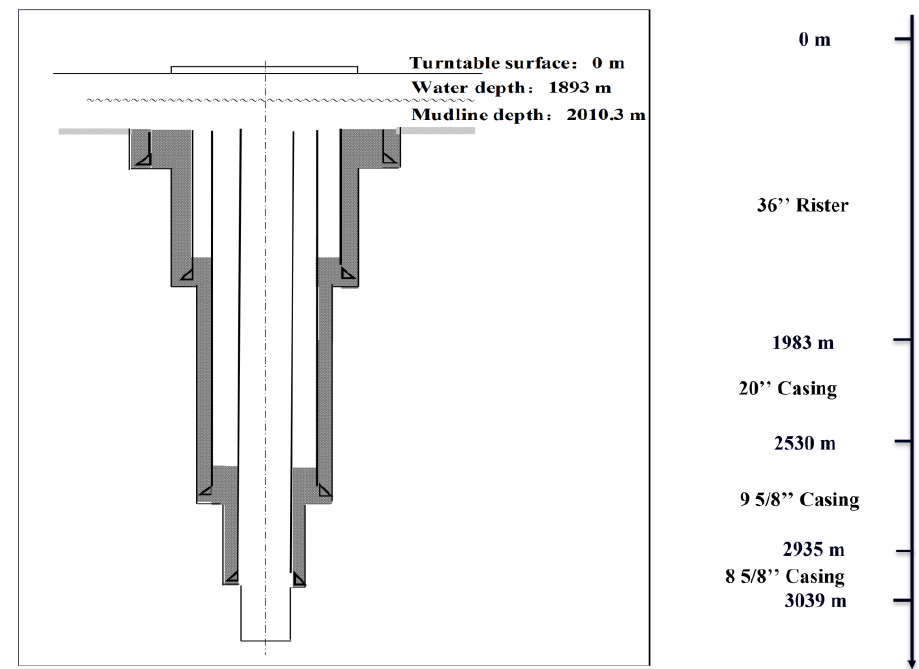
Figure 9. Structure of a normal pressure well body in the South China Sea.